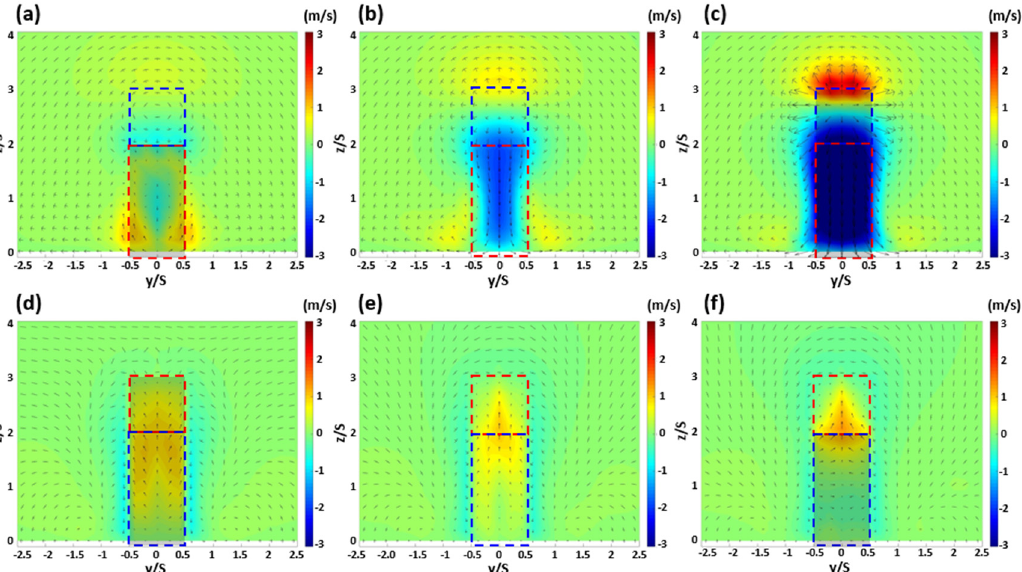
Figure 6. Wind field and vertical wind components of the first canyon (upper panel) and the second can-yon (lower panel); x/S = − 1.4 ( a ), − 1.0 ( b ), − 0.6 ( c ), 0.6 ( d ), 1.0 ( e ), 1.4 ( f ) with numerical simulations for step-up to step-down canyons; deep canyons. The windward buildings (red dotted box); leeward buildings (blue dotted box) of each canyon.